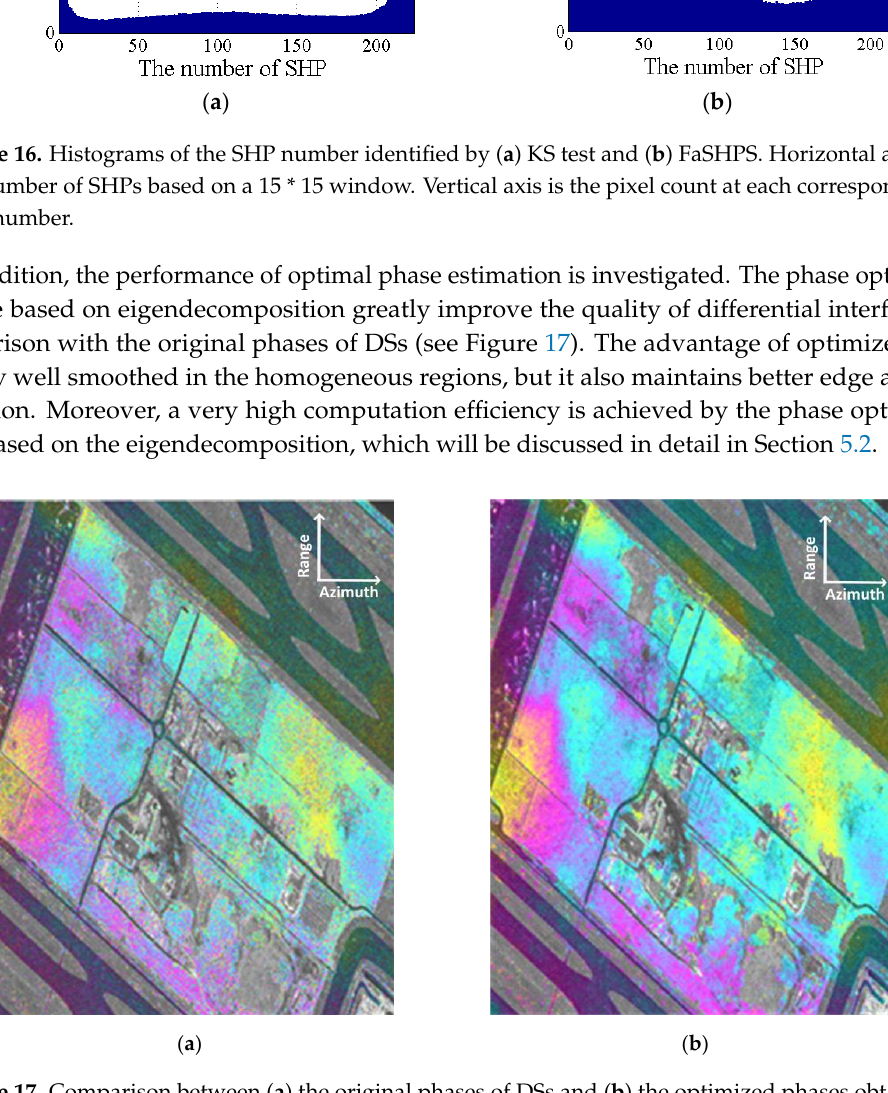
Figure 17. Comparison between ( a ) the original phases of DSs and ( b ) the optimized phases obtained by the eigendecomposition algorithm.